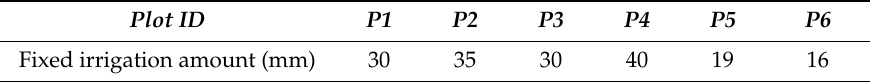
Table 2. Fixed volumes for irrigation injection, derived from real irrigation